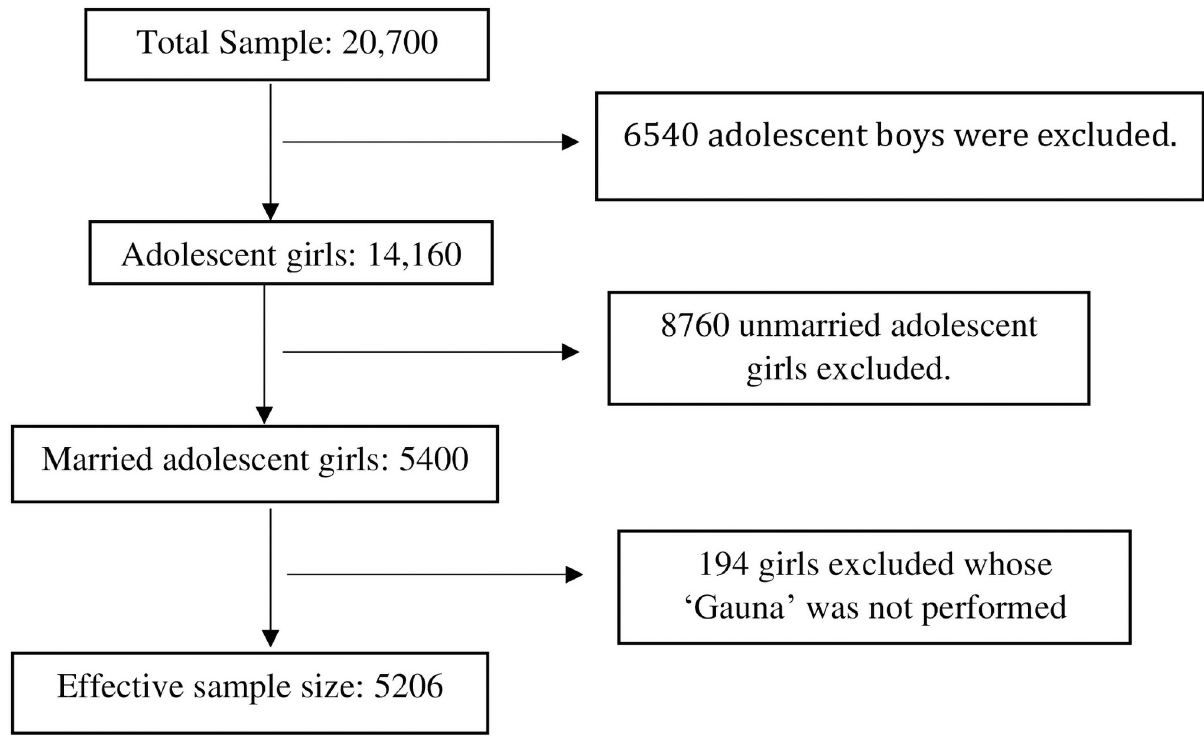
Fig 1. Sample selection criterion for the present